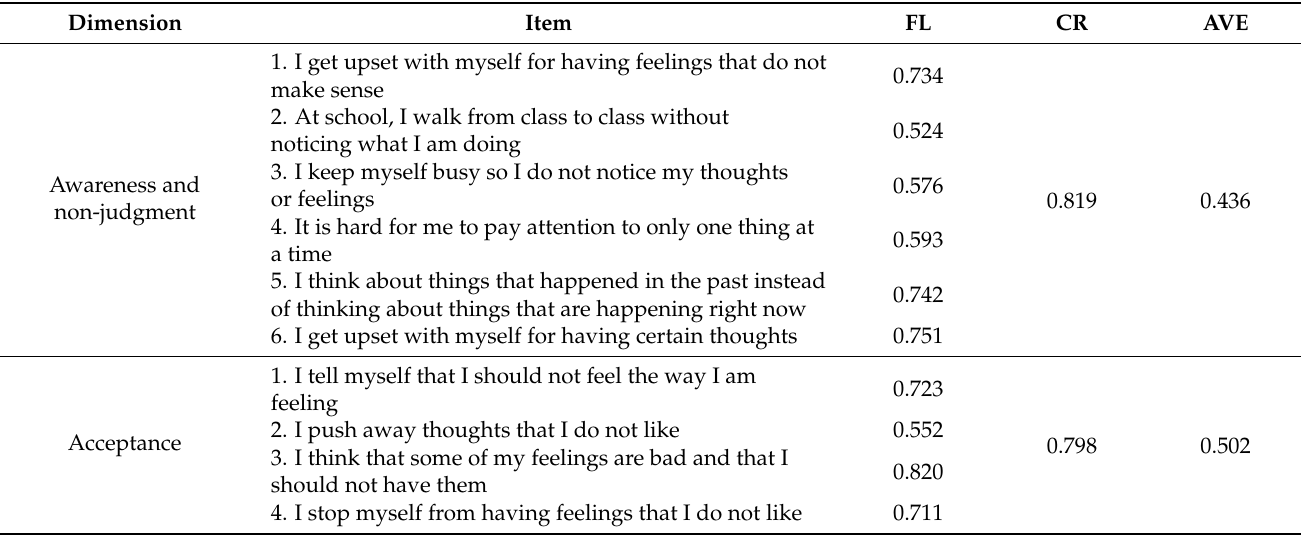
Table 4. Confirmatory factor analysis of the child and adolescent mindfulness